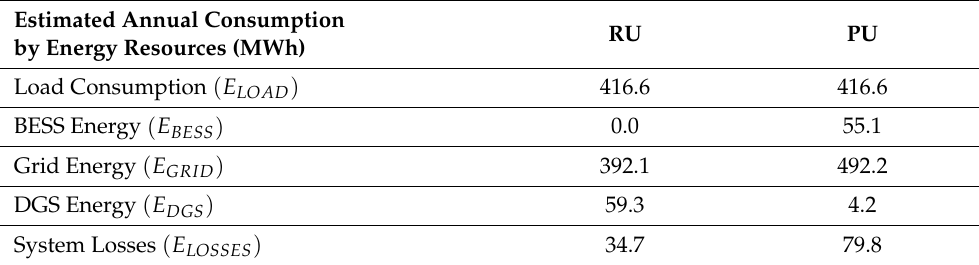
Table 5. Energy consumed by each energy resource for the reference unit (left column) and the pilot unit (right column) based annual estimations